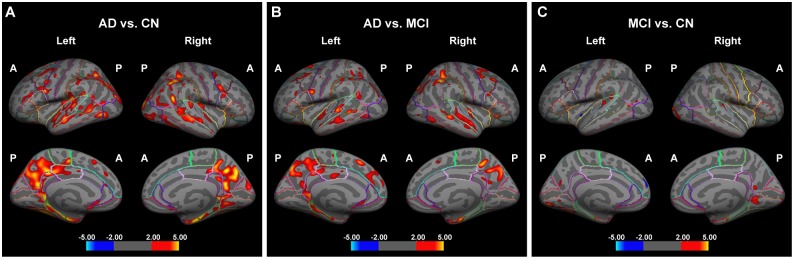
Analysis of cortical thickness to differentiate between AD patients and cognitively normal (CN) controls (A), AD patients and MCI patients (B), and MCI patients and CN controls (C) using FreeSurfer. A decreasing cortical thickness is indicated by red and yellow, and an increased cortical thickness is shown in cyan and blue. A, anterior; P, posterior.